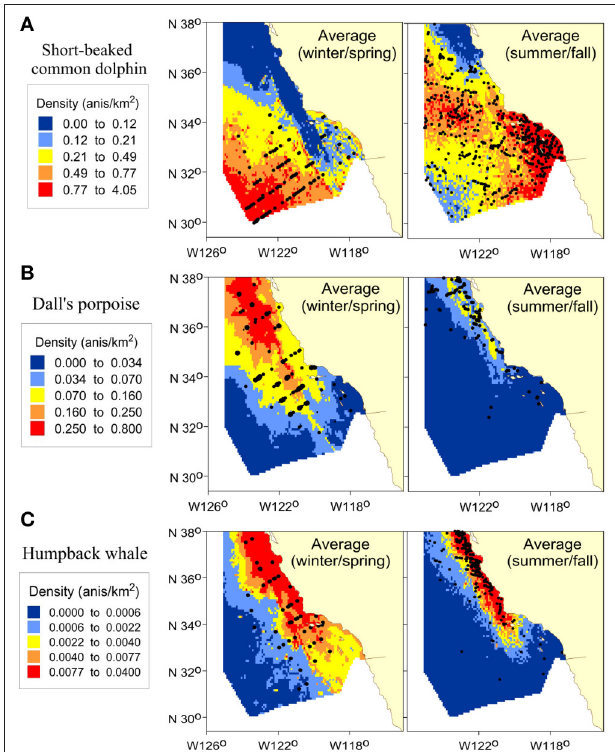
FIGURE 5 | Predicted densities from the winter/spring habitat-based density models from this study compared to summer/fall density predictions based on Becker et al. (2016) for (A) short-beaked common dolphin, (B) Dall’s porpoise, and (C) humpback whale. Panels show the multi-year average (Average) density based on predicted 8-day cetacean species densities covering the survey periods for winter/spring (January–April, 2005–2015) and summer/fall (July–November, 1991–2009). Density ranges are those selected for the winter/spring period and are consistent between seasons to emphasize differences. Predictions are shown for the study area (385,460 km 2 ). Black dots show actual sighting locations from the 2005–2015 winter/spring ship surveys and the 1991–2009 summer/fall ship surveys, respectively.